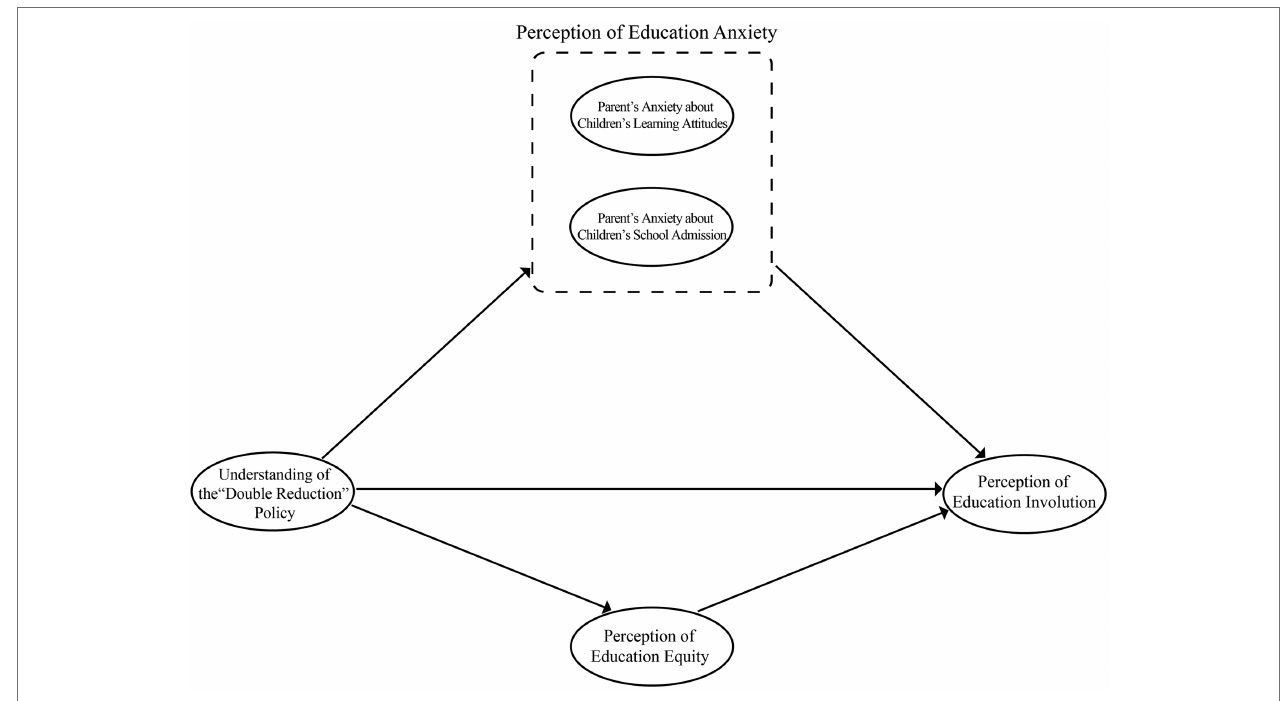
FIGURE 1 | Theoretical